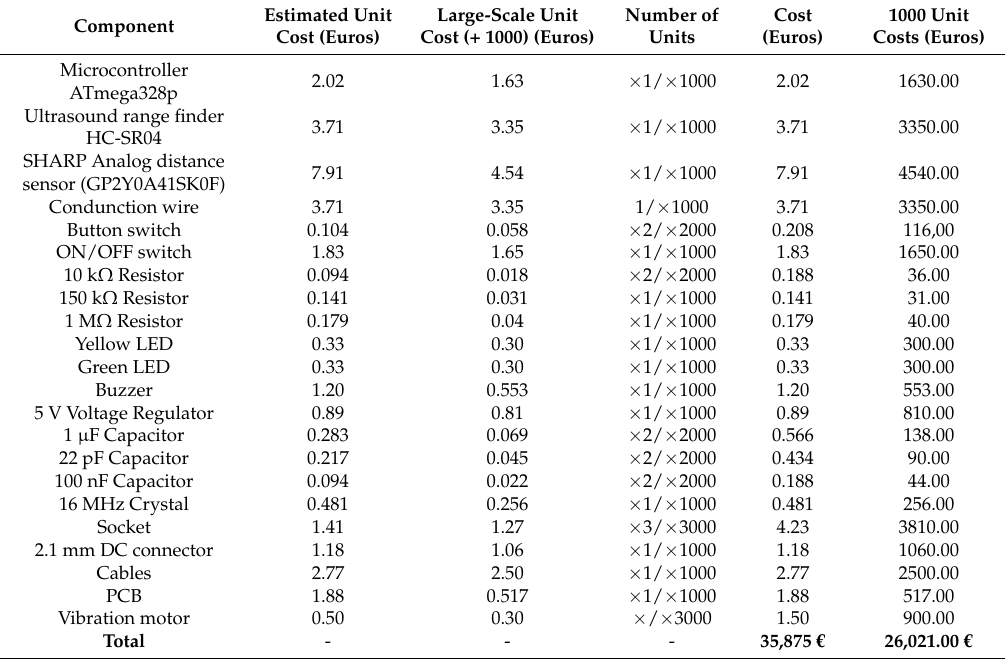
Table 2. List of NoSleep prototype